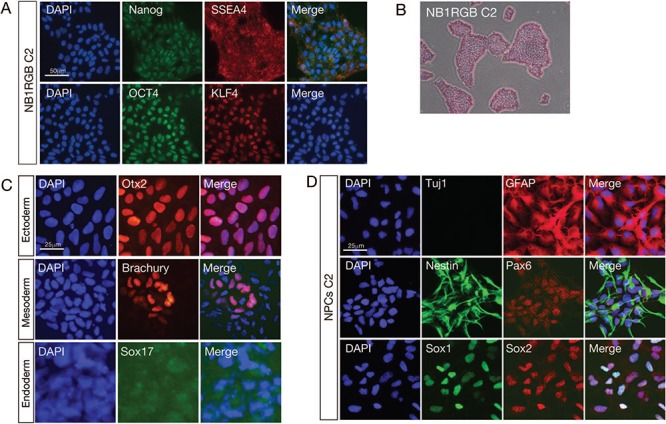

Generation of iPSCs and NPCs from human skin fibroblasts (NB1RGB). (A) To identify the PSC status of the established iPSC clone 2 (C2) from human skin fibroblasts (NB1RGB), cells were immunostained using PSC markers Nanog, SSEA4, OCT4 and KLF4. The cell nucleus was counterstained with 4′,6-diamidino-2-phenylindole (DAPI). (B) iPSC-like colonies were stained with alkaline phosphatase staining. (C) To confirm pluripotency, iPSCs were differentiated into three germ layers and stained with germ-layer markers Otx2, Brachury and Sox17 for the ectoderm, mesoderm and endoderm, respectively. (D) iPSCs were differentiated to neural progenitor cells (NPCs) and stained with neural stem cell markers GFAP, Nestin, Pax6, Sox1 and Sox2 and the differentiated neuron marker β-III Tubulin (Tuj1). NPCs were positive for all the NPC markers except Tuj1. Scale bar represents 25 μm or 50 μm, as indicated. iPSCs = induced pluripotent stem cells, NPCs = neural progenitor cells, PSC, pluripotent stem cell = DAPI, 4′,6-diamidino-2-phenylindole.